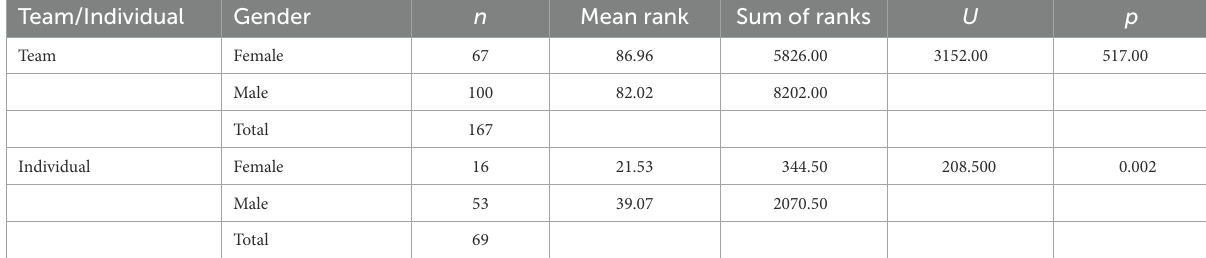
TABLE 6 Mann–Whitney U test results of the coach’s scores on social support behaviors by gender.